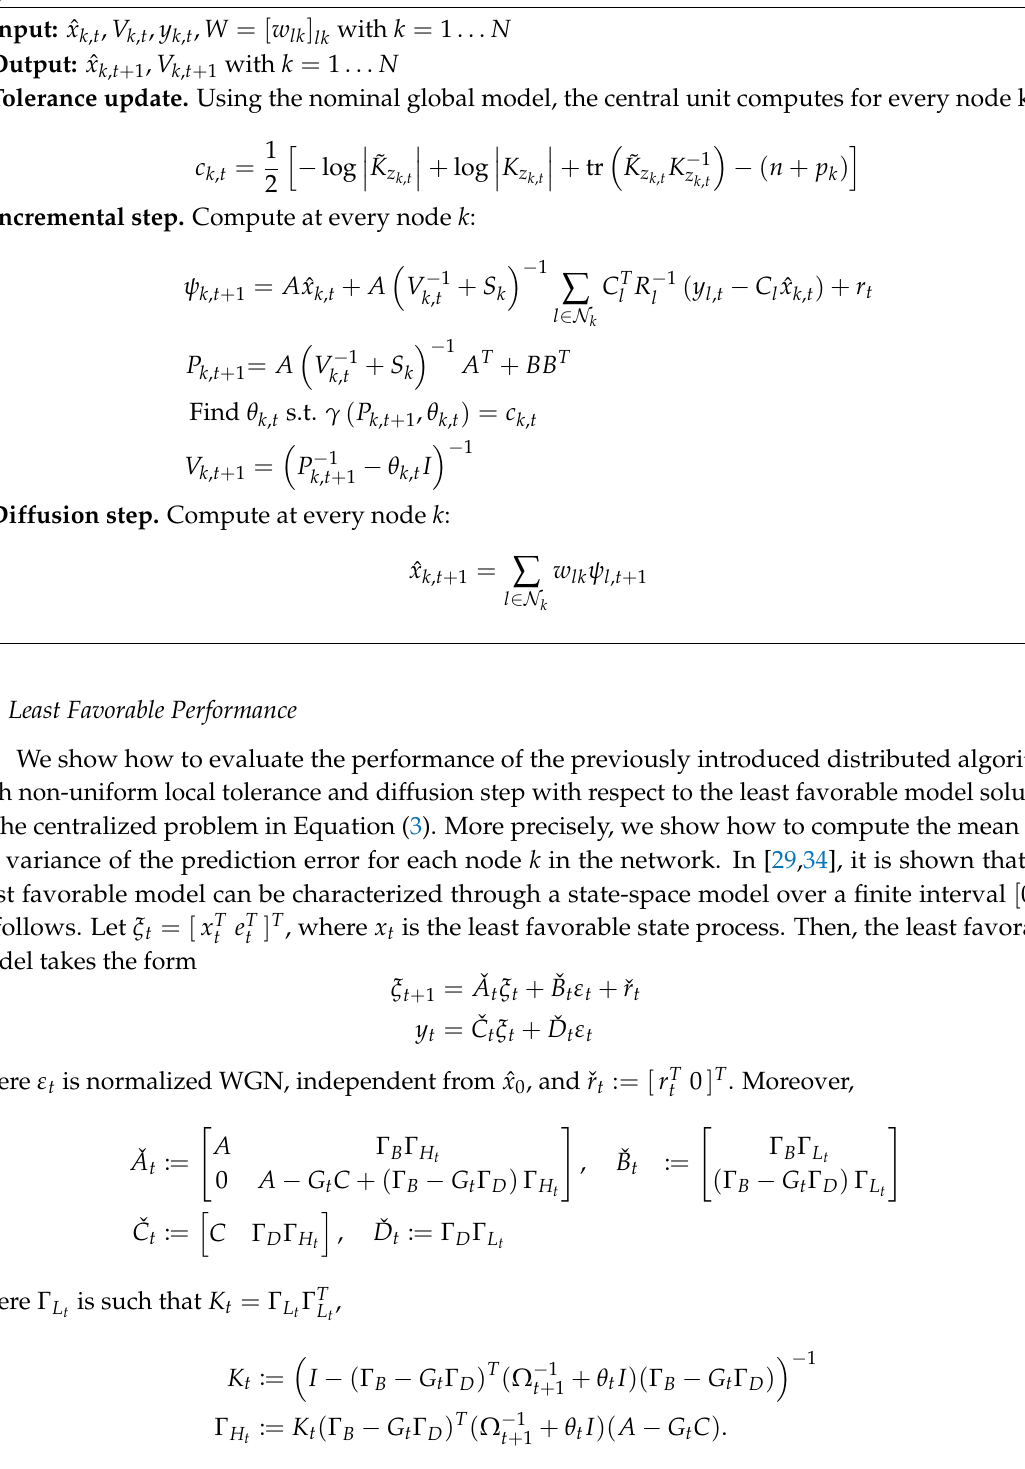
Algorithm 2 Distributed robust Kalman filter with non-uniform local tolerance at time t